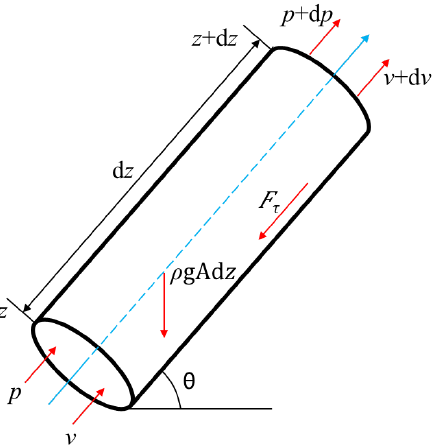
Figure 3. Schematic diagram of section pressure drop.